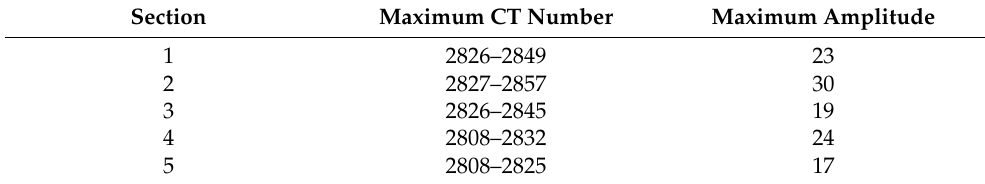
Table 1. The maximum CT numbers in the ROI.